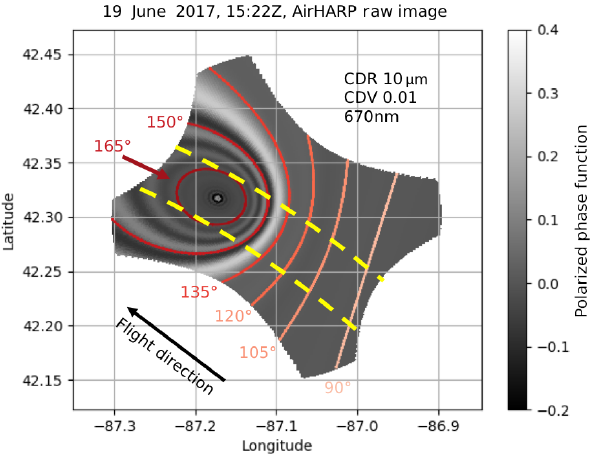
Figure 3. The scattering angle coverage typical of an instantaneous AirHARP wide-FOV observation, projected to simulate a scene over Lake Michigan on 19 June 2017 at 15:22Z (a) . The cloudbow in this simulation represents a simulated cloudbow at 670nm, with CDR 10um and CDV 0.01, with scattering angle isolines from 90 to 165 ◦ shown (solid lines). Note that the cloudbow pattern occurs within 135–165 ◦ in scattering angle, and the location of the cloud- bow in the FOV depends on time of day, flight orientation, and solar geometry. Note that the only portion of the image that is eligible for retrieval lies inside the region defined by along-track lines tangent to the 165 ◦ scattering angle isoline (yellow dotted